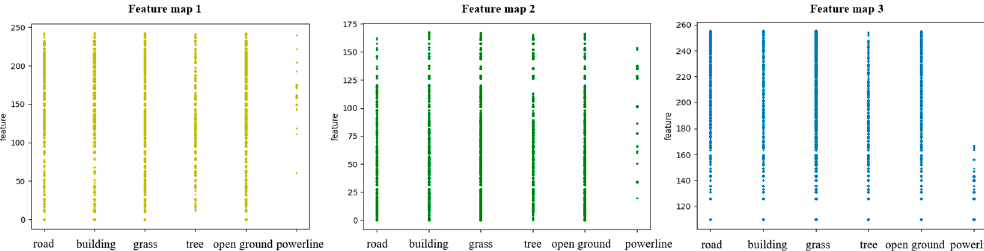
Figure 2. The feature distribution of spectral intensity in 3 channels of point cloud.